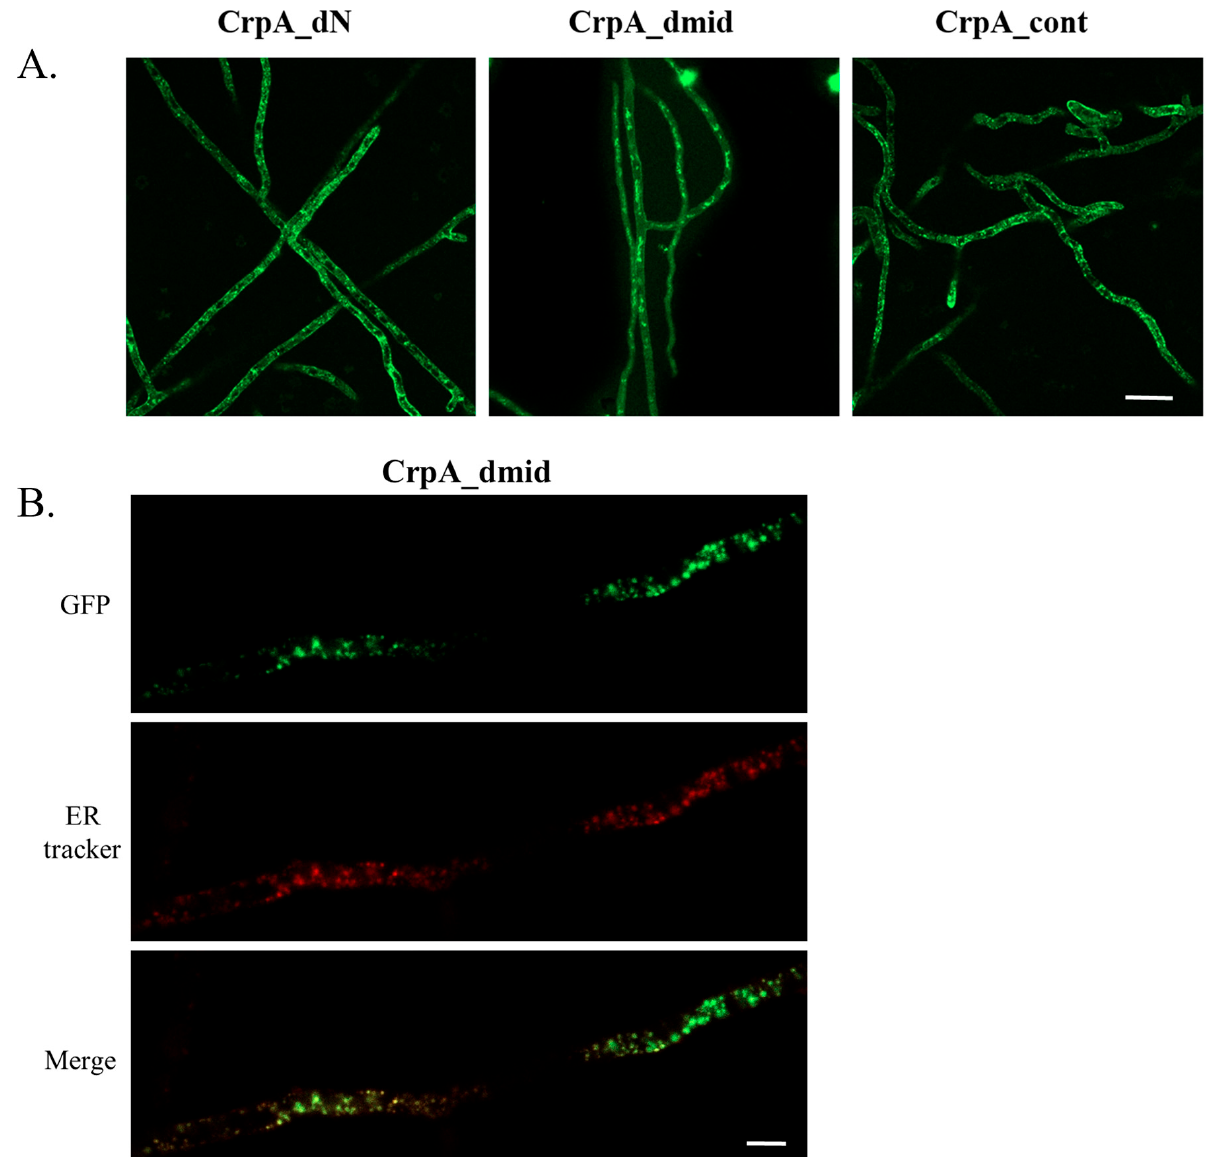
Figure 4. The CrpA intracellular loop (amino acids 542–556) is essential for the localization of CrpA to the cell surface. ( A ) Subcellular localization of CrpA_dN-GFP (N-terminal amino acids 1–211 deleted), CrpA_dmid-GFP, (intracellular-loop amino acids 542–556 replaced), and CrpA-GFP full length protein (CrpA_cont). Fluorescence images were acquired using confocal microscopy under identical exposure settings. ( B ) CrpA_dmid-GFP localization (top panel) after Cu shift and staining with ER-Tracker Red (lower panel) (size-bar = 2.5 µ m). In both panels ( A , B ), conidia were grown on coverslips in liquid MMVUU for 16 h at 37 ◦ C. Following that, 2.5 µ M Cu was added for 2 h. Fluorescence images were then acquired using confocal